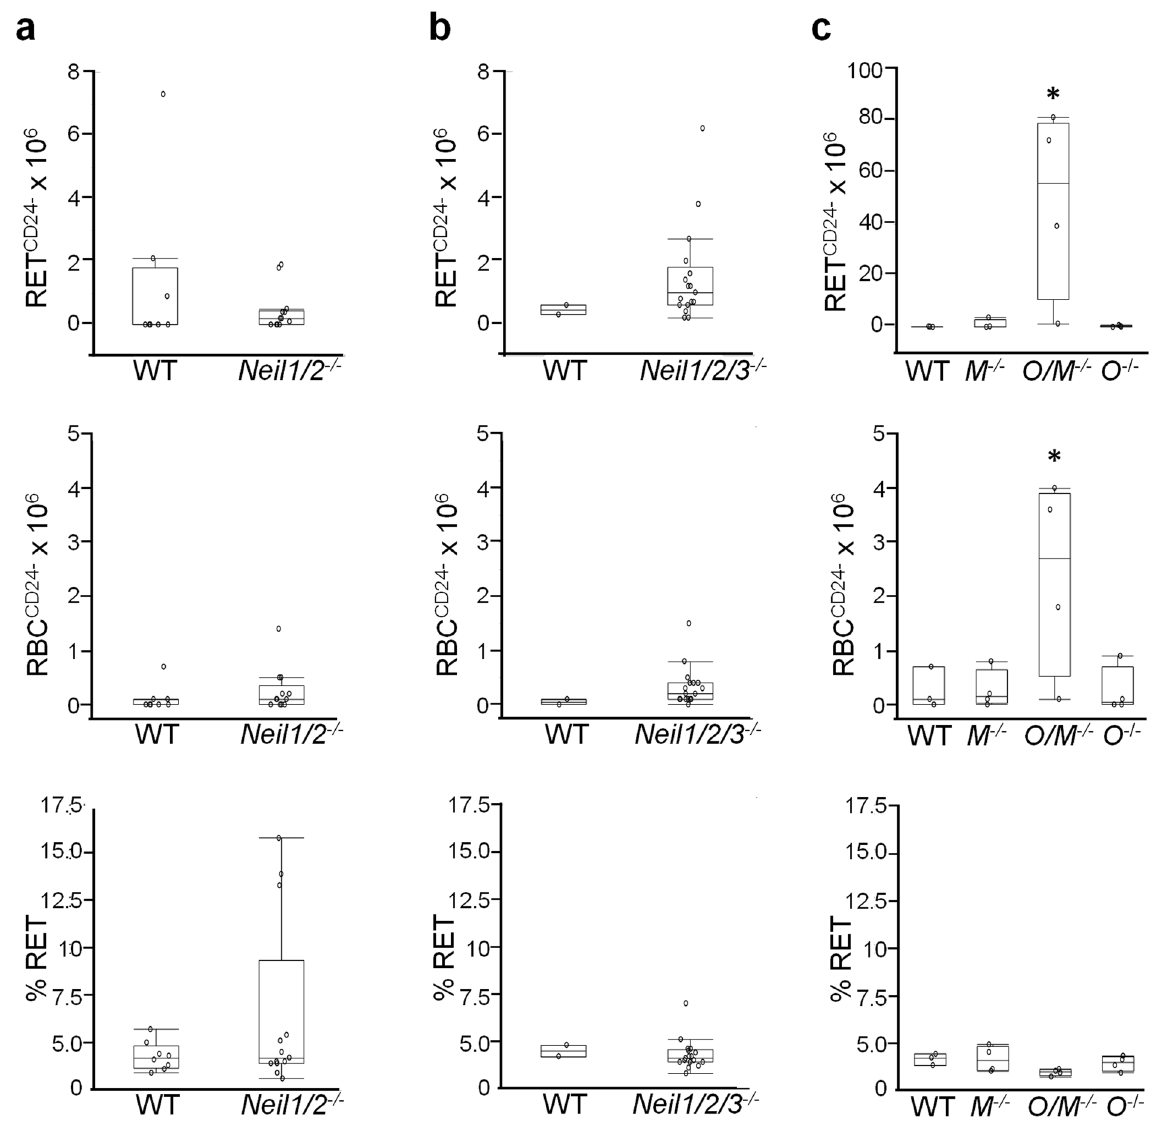
Figure 5. Phenotypic mutation frequencies measured by the Pig-a gene mutation assay. Frequencies of mutant phenotype reticulocytes (RET CD24 − ), erythrocytes (RBC CD24 − ) and percentage reticulocytes (% RET) were determined in ( a ) 18 months-old WT (n = 8) and Neil1 − / − /Neil2 − / − ( Neil1/2 − / − ) (n = 13); ( b ) 23 months-old WT (n = 2) and Neil1 − / − /Neil2 − / − /Neil3 − / − ( Neil1/2/3 − / − ) (n = 17) mice and c) 6 months-old WT (n = 3), Mutyh − / − ( M − / − ) (n = 3), Ogg1 − / − /Mutyh − / − ( O/M − / − ) (n = 3), and Ogg1 − / − ( O − / − ) (n = 4) mice. Results are presented for three separate experiments (a – c) . Each data point represents one mouse; and groups are summarized as box-plots of at least two individuals. Groups that are significant different (p < 0.05) from control group (WT) are marked with an asterisk dependent on the distribution of the data, that is (a) non-parametric Wilcoxon test, (b) t-test and (c) Dunnett’s